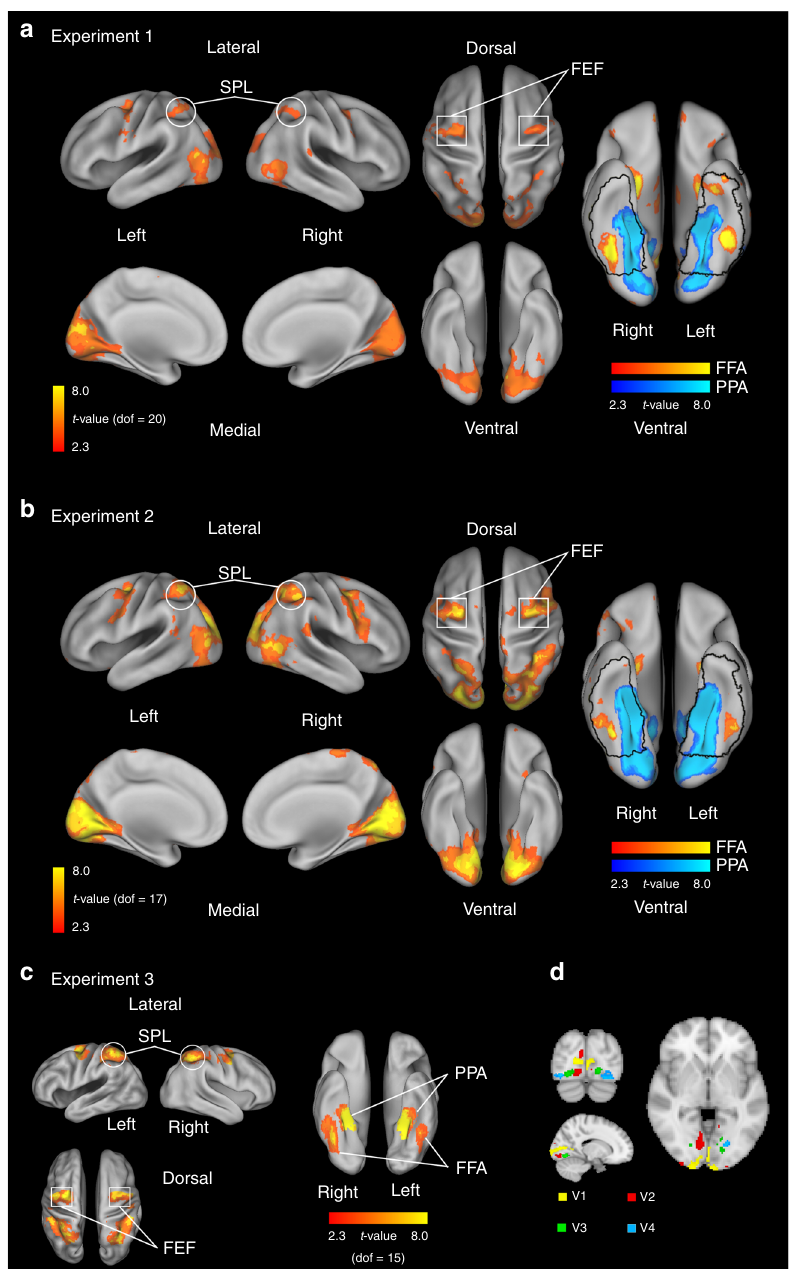
Fig. 2 Visualization of ROIs. a Localizer results for Experiment 1. The frontal eye fi elds (FEF) and the superior parietal lobule (SPL) were identi fi ed based on the group-level statistical maps of the fi xation pattern contrast Face + House + inverted Face for Experiment 1 (signi fi cant on cluster level p < 0.05, one- sample t test, cluster forming threshold z > 2.3, left). Fusiform face area (FFA) and parahippocampal place area (PPA) were identi fi ed based on the visual localizer group-level statistical map of the contrast Face-House ( z >2.3; uncorrected, right). The statistical maps are projected onto an in fl ated brain template using Caret 5.64 with the PALS-B12 atlas 36 . b Localization of FEF, SPL (left), FFA and PPA (right) for Experiment 2 (with the same thresholds as Experiment 1). c Localization of FEF, SPL (left), FFA and PPA (right) for Experiment 3. FEF and SPL were de fi ned identi fi ed based on the group-level statistical maps of the fi xation pattern contrast Self-face + Self-house + Other-face + Other-house for Experiment 3 (signi fi cant on cluster level p <0.05, one-sample t test, cluster forming threshold z >2.3, left). FFA was identi fi ed based on the visual localizer group-level statistical map of the contrast Face>all other pictures (houses, scenes, bodies, objects, scrambled pictures), and PPA based on the contrast (House + Scene)>all other pictures (faces, bodies, objects, scrambled pictures) ( z > 2.3; uncorrected, right). d Localization of early visual areas (V1 – V4) were de fi ned by the probability maps in the Juelich Histological Atlas 25 The replication of the classi fi cation results in the absence of univariate activation differences shows that the information content of the activation patterns is independent of overall activation levels. Again, gaze tracks could be discriminated in the two visuomotor ROIs (SPL and FEF) but also in FFA and PPA, again suggesting that FFA and PPA contribute to visuomotor processes.